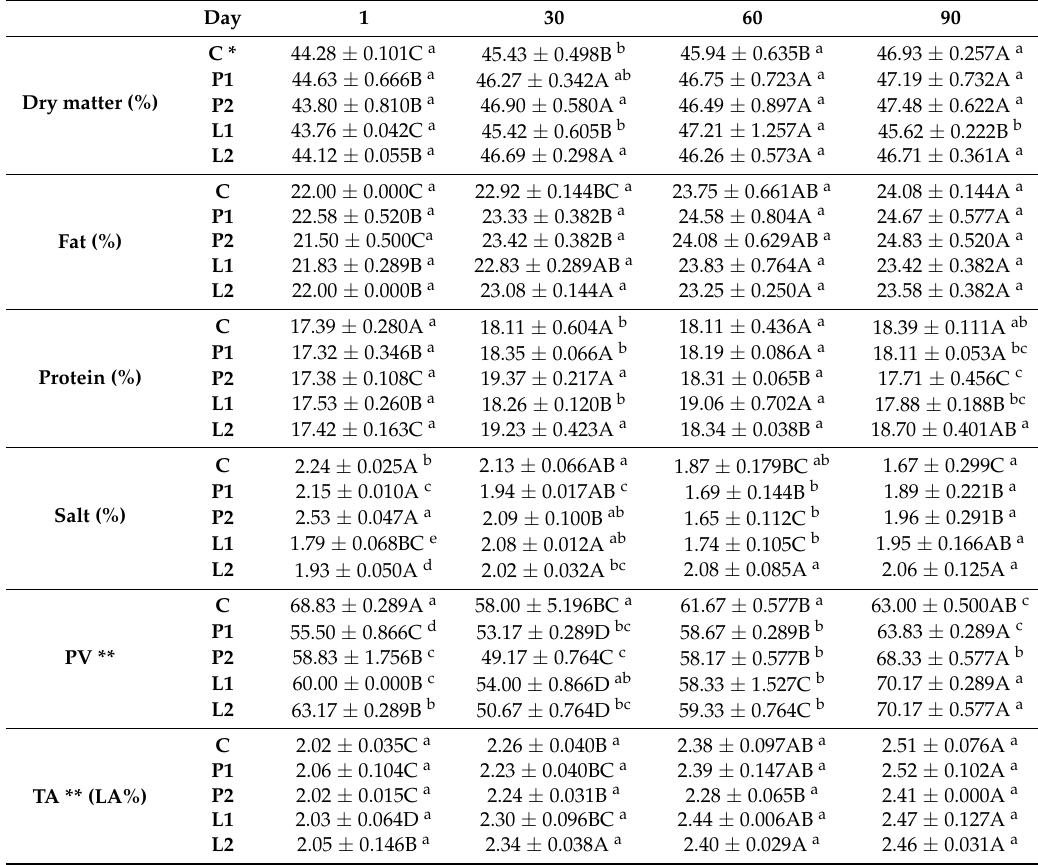
Table 3. Titratable acidity, penetrometer values and mean composition of experimental White cheeses during ripening ( n =